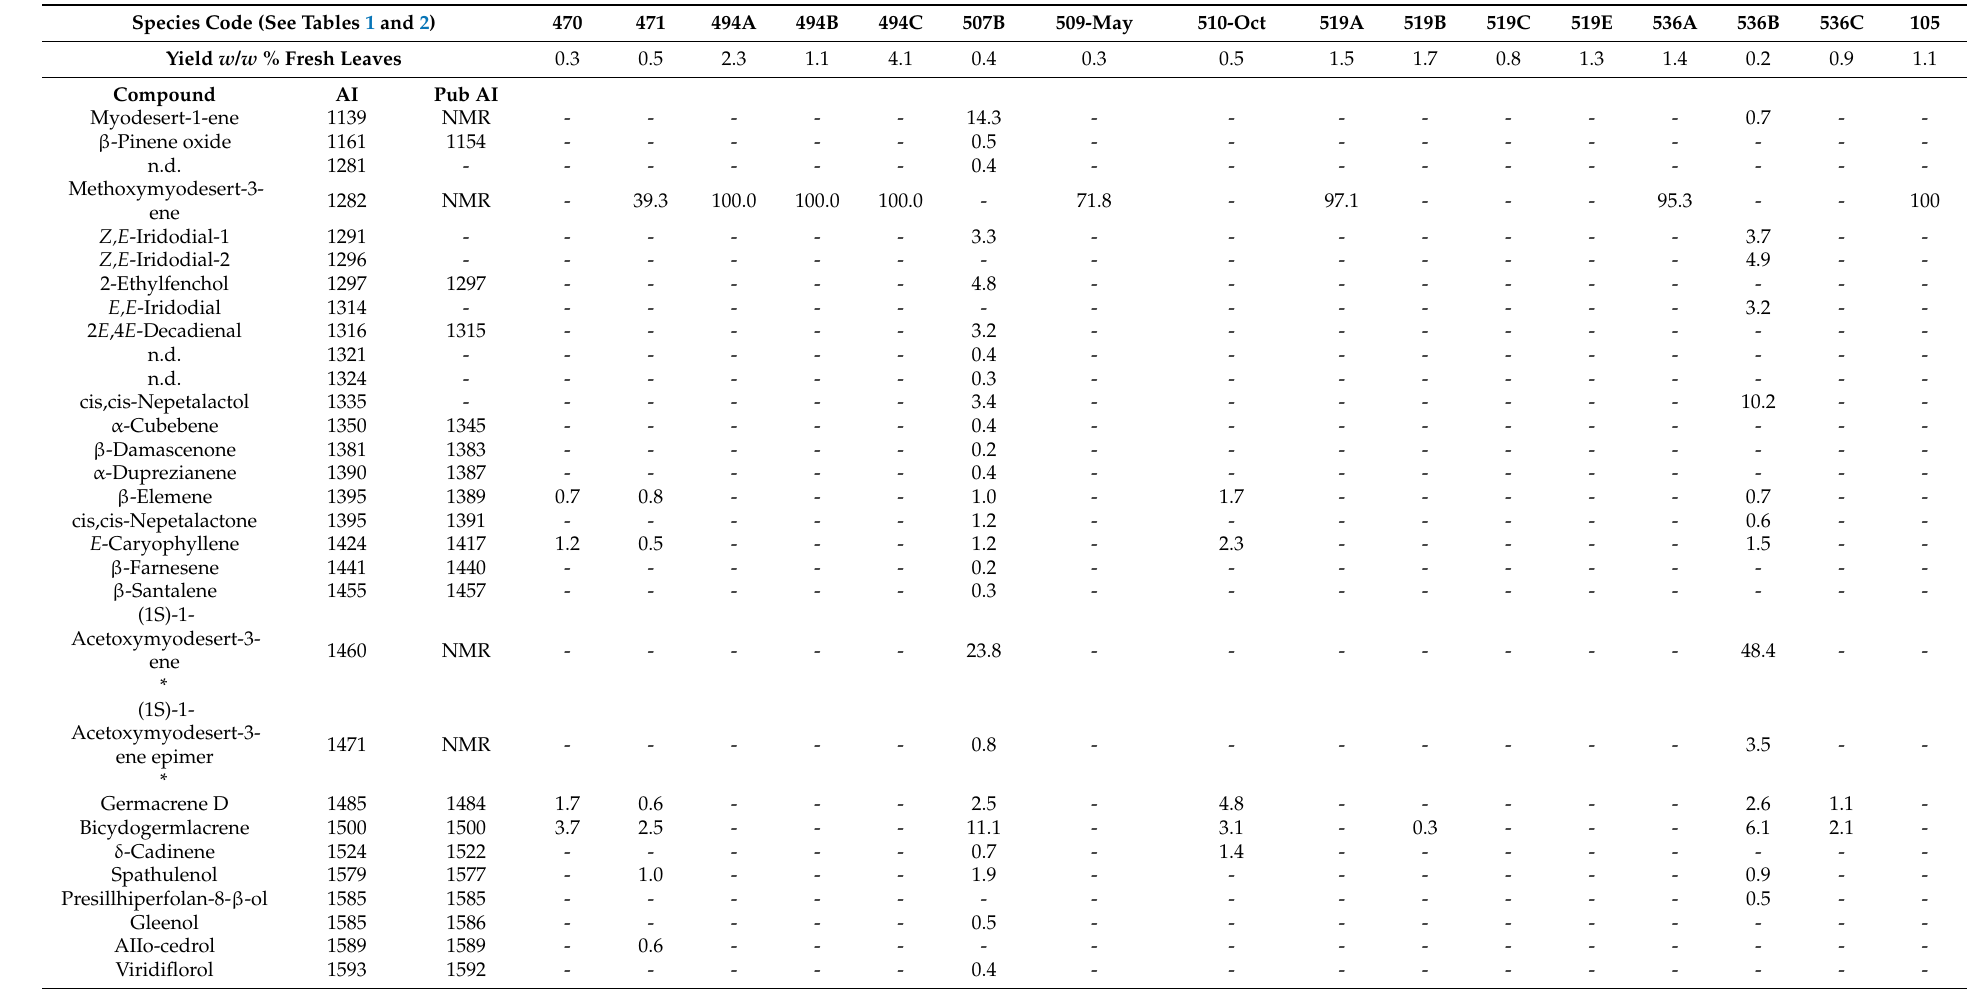
Table 3. Essential oil chemistry of specimens determined to be Eremophila deserti